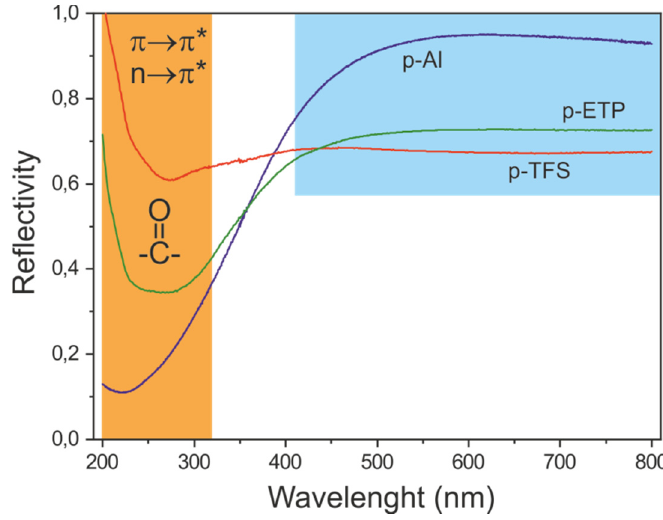
Figure 10. UV-Vis reflectivity of polyaleuritate-coated metal supports. Blue and orange regions correspond to the visible and UV regions, respectively.